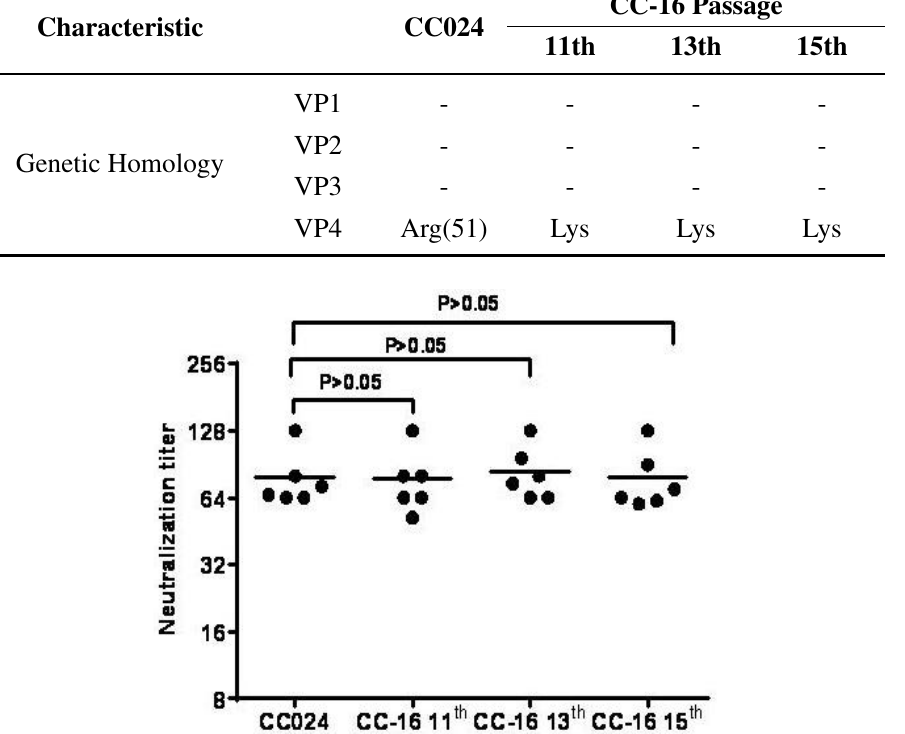
Table 1. Genetic stability of CC-16 strain at different passages in Vero cells.